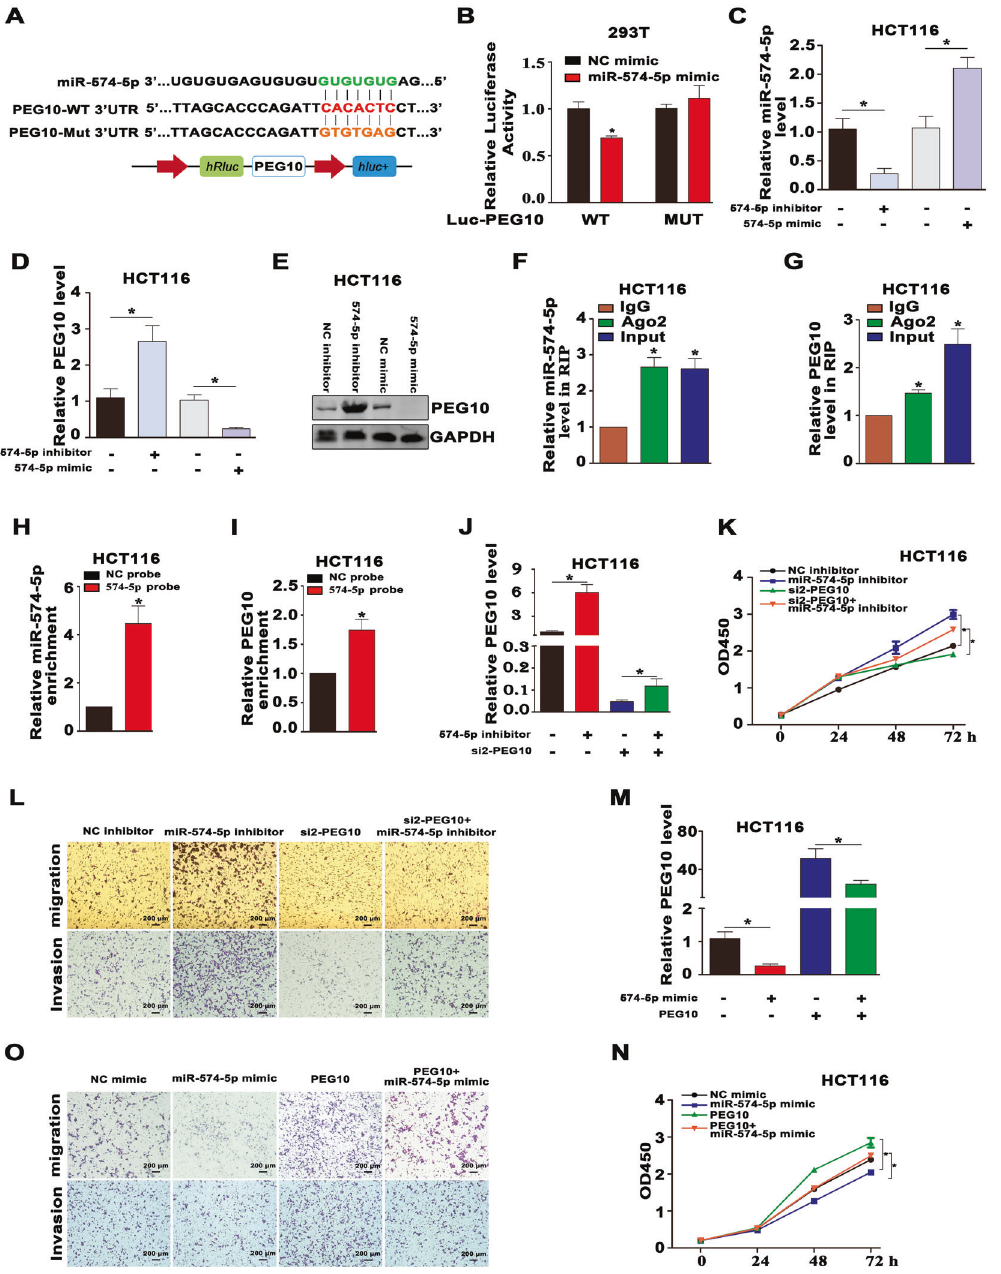
Fig. 6 PEG10 is a direct target of miRNA-574-5p. A Schematic diagram of Mut-PEG10 3 ′ UTR and WT-PEG10 3 ’ UTR LR vectors. B 293T was cotransfected with miRNA-574-5p mimics and Mut or WT PEG10 3 ′ UTR LR vectors, and the activities of the LR were detected. C , D The mRNA levels of miRNA-574-5p and PEG10 were assessed by RT-qPCR in CRC cells transfected with miRNA-574-5p inhibitor or mimic. E The protein level of PEG10 was assessed by WB in CRC cells transfected with miRNA-574-5p inhibitor or mimic. F , G Ago2 RIP was conducted to detect endogenous Ago2 binding to RNA; IgG was employed as the control. The levels of miRNA-574-5p and PEG10 were detected by RT-qPCR, and shown as fold-enrichment in Ago2 compared to lgG. H The ef fi ciency of the biotinylated miRNA-574-5p probe in HCT116 cells was veri fi ed by RT-qPCR. I The relative expression of PEG10 enriched by the miRNA-574-5p probe in HCT116 cells was determined by RT-qPCR. J – L RT-qPCR, CCK8, and transwell assays were conducted to measure the expression of PEG10 and cell proliferation, migration, and invasion in HCT116 cells after cotransfection with miRNA-574-5p inhibitor, control and PEG10 siRNA. M – O RT-qPCR, CCK8, and transwell assays were conducted to measure the expression of PEG10 and cell proliferation, migration, and invasion in HCT116 cell line after cotransfection with miRNA-135b mimic, control, and PEG10 overexpression the luciferase activities in cells containing NALT1 WT reporter, determine the interactions between NALT1 and miRNA-574-5p, whereas no obvious difference was found in cells containing a luciferase reporter (LR) containing mutant (Mut) or wild-type NALT1 Mut reporter (Fig. 5G). In the rescue experiment, the (WT) NALT1 cDNA sequences was constructed according to the downregulation of NALT1 in HCT116 and HT29 cells reversed the putative binding sites of NALT1 and miRNA-574-5p. The LR increased expression of NALT1 and enhancement of cell assays revealed that miRNA-574-5p mimic transfection inhibited